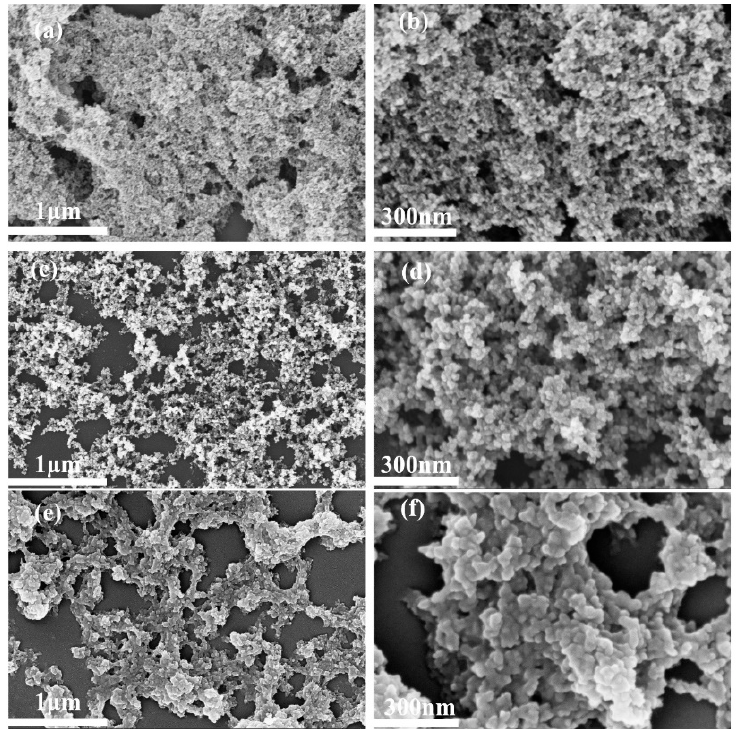
Figure 1. FESEM diagrams of silica aerogels with different particle sizes: 15 μ m ( a , b ), 30 μ m ( c , d ), 50 μ m ( e – f ).